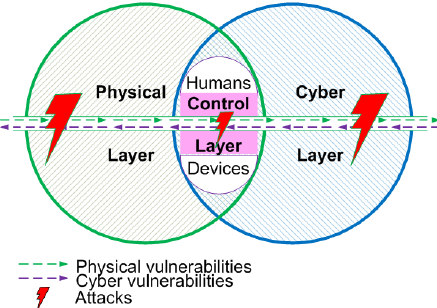
Figure 1. Interaction between physical and cyber layer